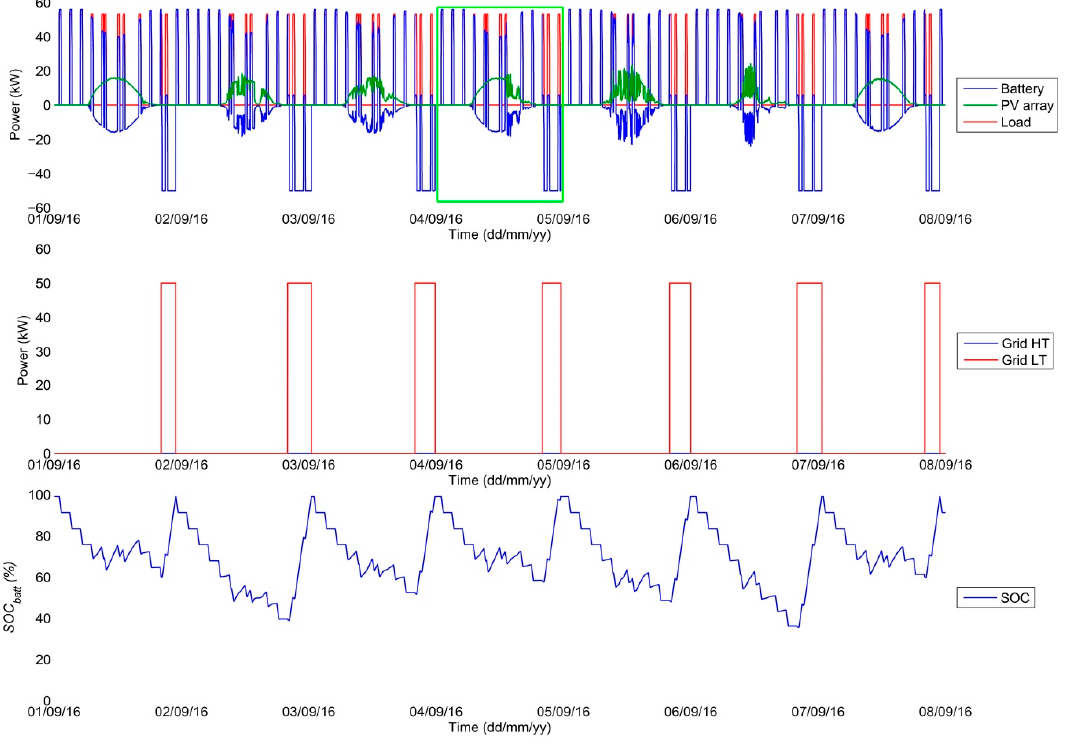
Figure 19. Resulting profiles for simulation of individual states—general overview, scenario B.